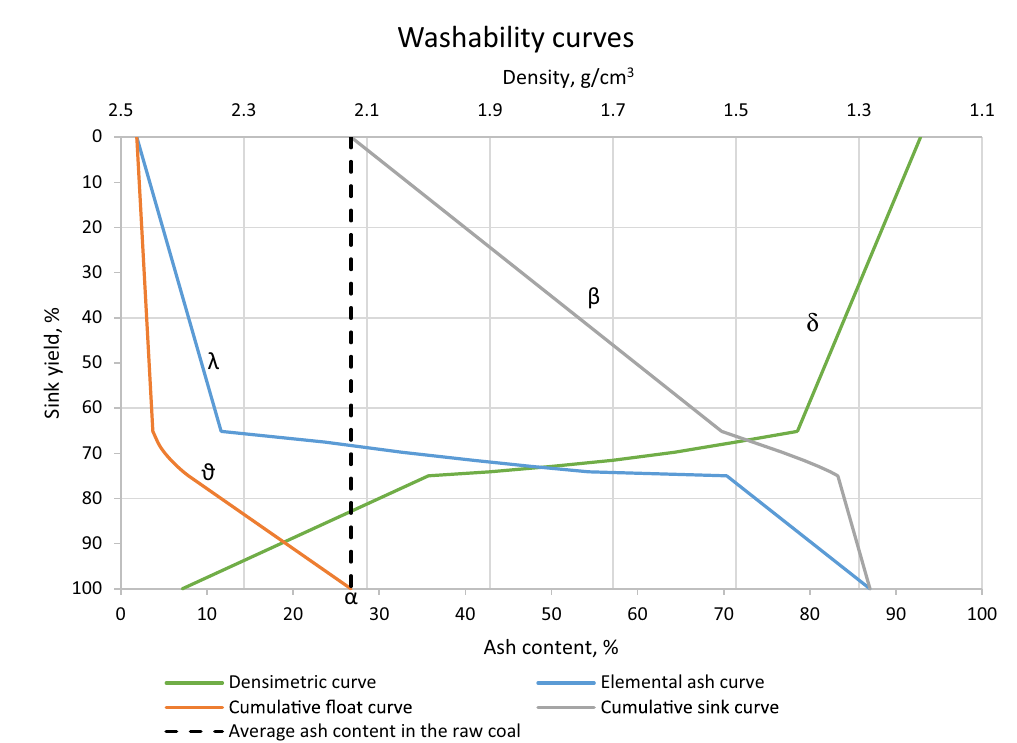
Fig. 4 Washability curves of material No. 1 (0–20 mm) Table 2 Density distribution of material No. 1 (grain-size class: 0–20 mm) Curve coordinates